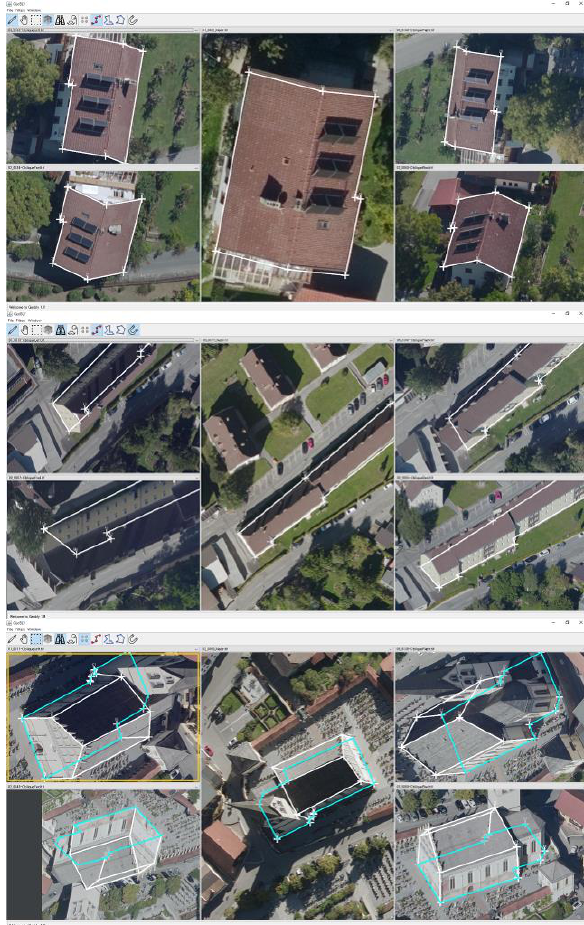
Figure 7. Image measurements in the GEOBLy tool: “Traditional” roof edge measurements (top) and measurements of complete building footprints (middle and